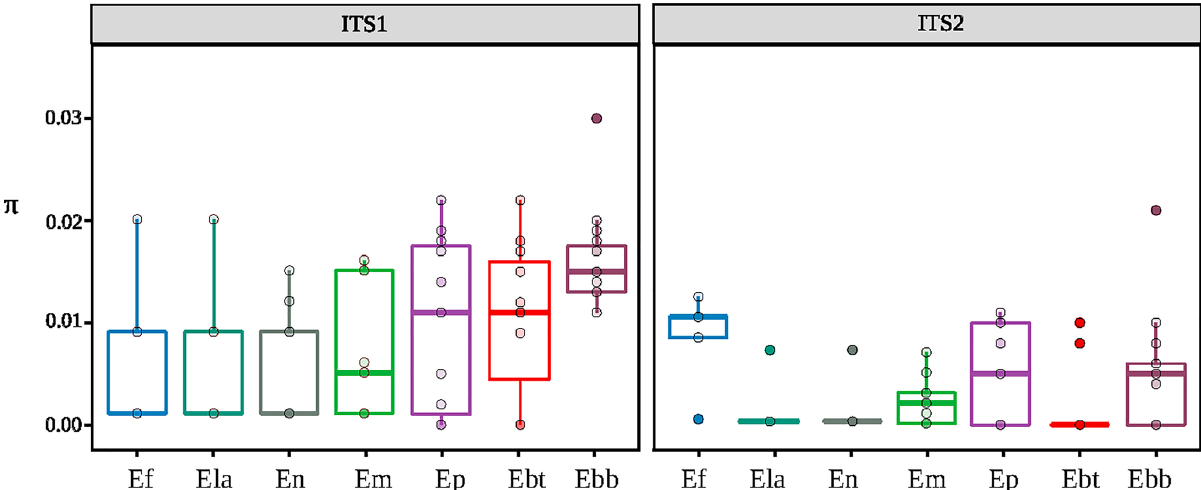
Figure 1. Boxplot depicting the nucleotide diversity (π) for ITS1 and ITS2 samples. Nucleotide polymorphism was estimated for each Erysimum individual as the average number of nucleotide differences per site between two sequences (Nei and Li 47 ). E. baeticum (Ebb, ploidy 8x), E. bastetanum (Ebt, ploidy 4x and 8x), E. popovii (Ep, ploidy 4x and 10x), and one population of E. mediohispanicum (Em, ploidy 4x) are polyploids. E. nevadense (En), E. fitzii (Ef), two populations of E. mediohispanicum (Em), and E. lagascae (Ela) are